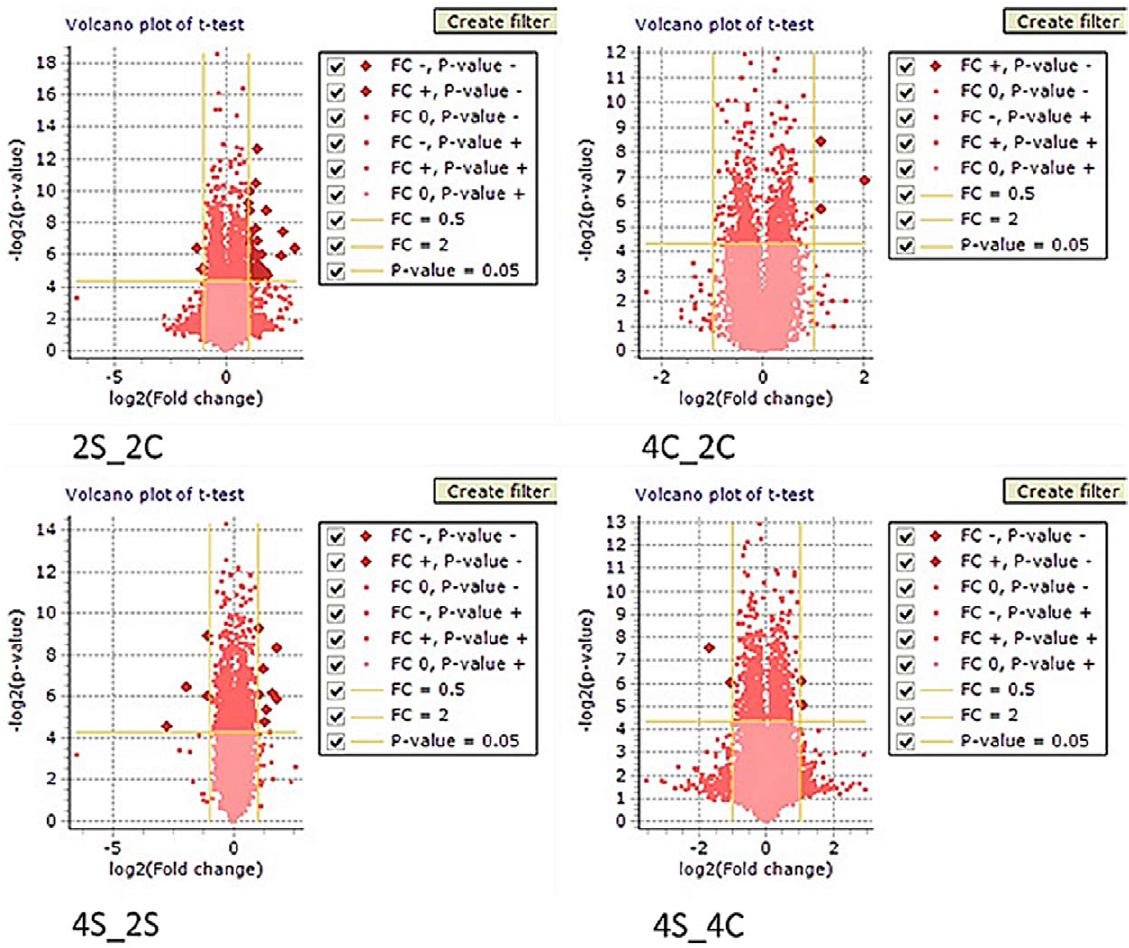
Figure 4. mRNA microarray expression analysis in animals after two weeks of stress (2WSTRESS), recovery from stress (4WSTRESS) and appropriate controls for each time point (2WCONTROL, 4WCONTROL). Genes with a 2-fold difference and a p-value of p , 0.05 are shown in logarithmic scale (log 2 ). Genes that were changed are represented as dark-red diamonds, in top-left (down-regulated) and top-right (up- regulated) parts of each figure. 2S_2C – groups of 2WSTRESS vs. 2WCONTROL, 4C_2C – 4WCONTROL vs. 2WCONROL, 4S_2S – 4WSTRESS vs. 2WSTRESS, 4S_2C – 4WSTRESS vs. 2WCONTROL.